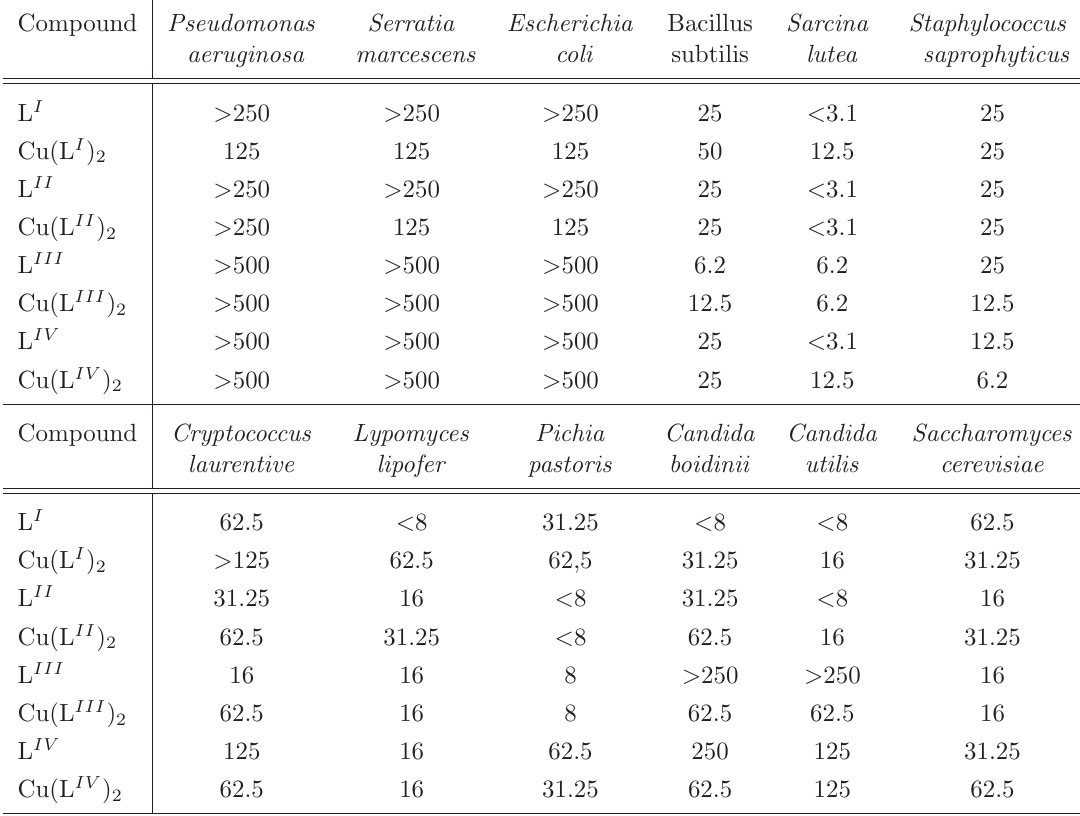
Table 3 Antimicrobial activities of the free ligands I – IV and their Cu (II) complexes, evaluated by minimum inhibitory concentration (MIC, µ g · mL − 1